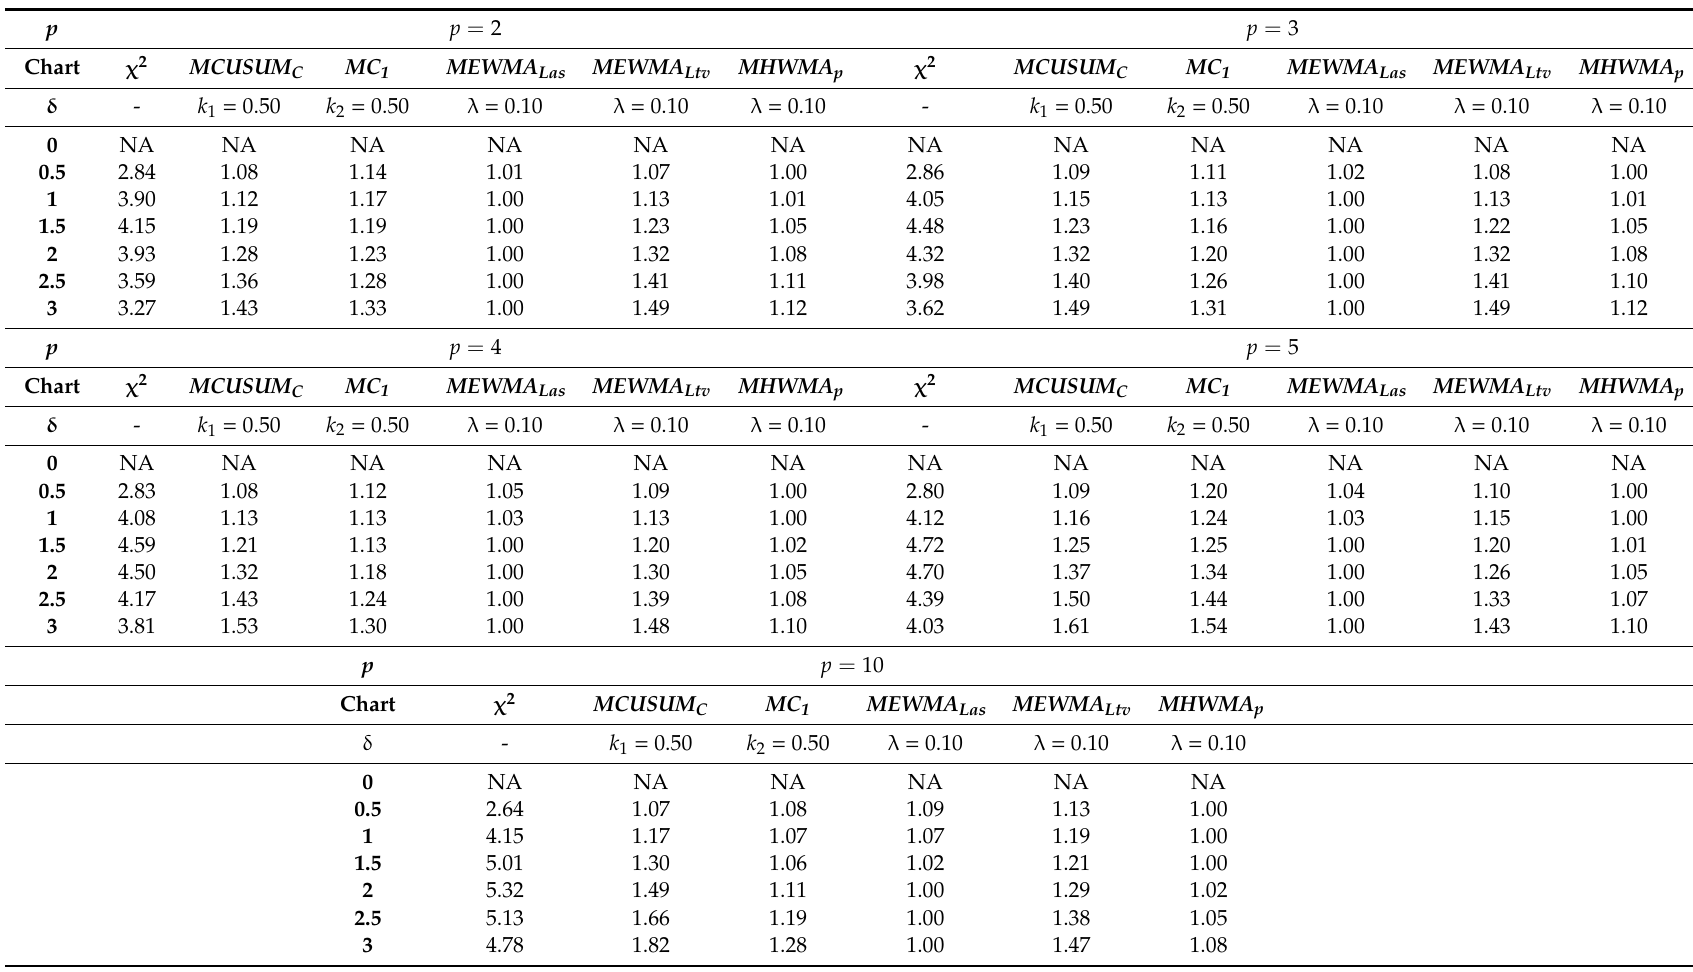
Table 2. Cumulative relative average run length (RARL) values for di ff erent